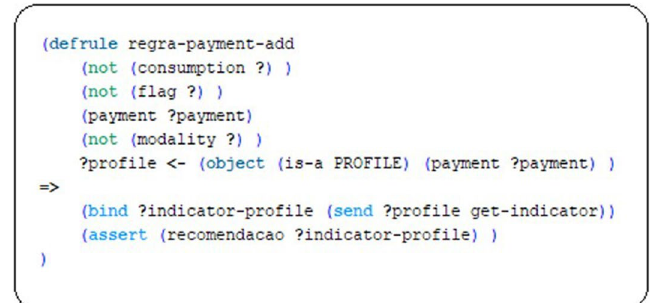
Fig. 4 Example of an applied rule